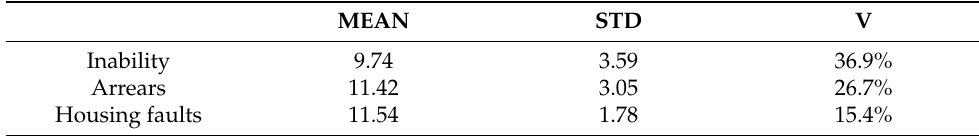
Table 2. Descriptive statistics of the variables used to measure energy poverty levels. MEAN STD V